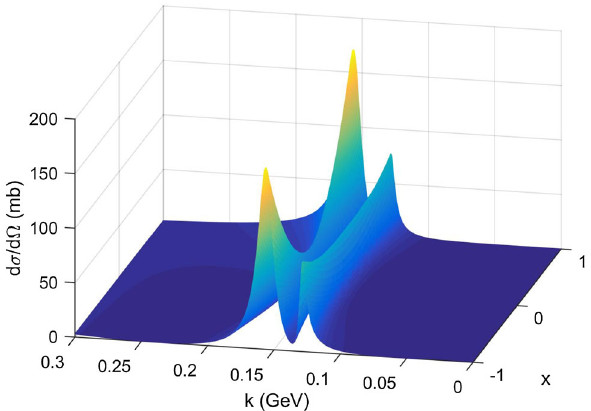
Fig. 5 Differential cross section of the π(cid:2) b interaction